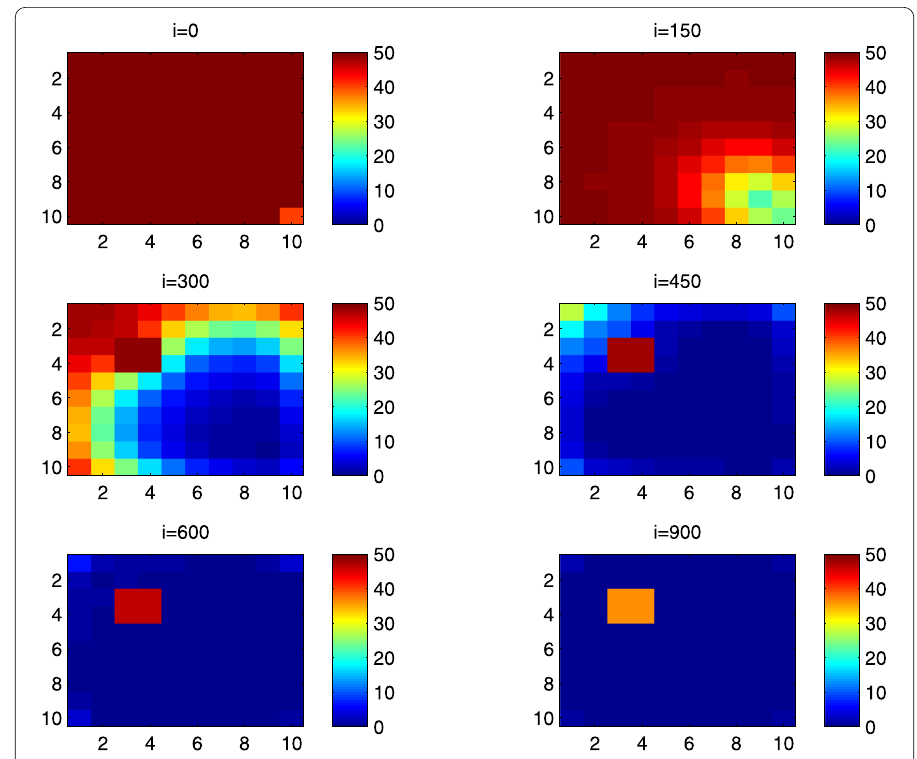
Figure 8 S Cpq behavior in the presence of optimal controls (11). The case when the disease starts from the corner C 11